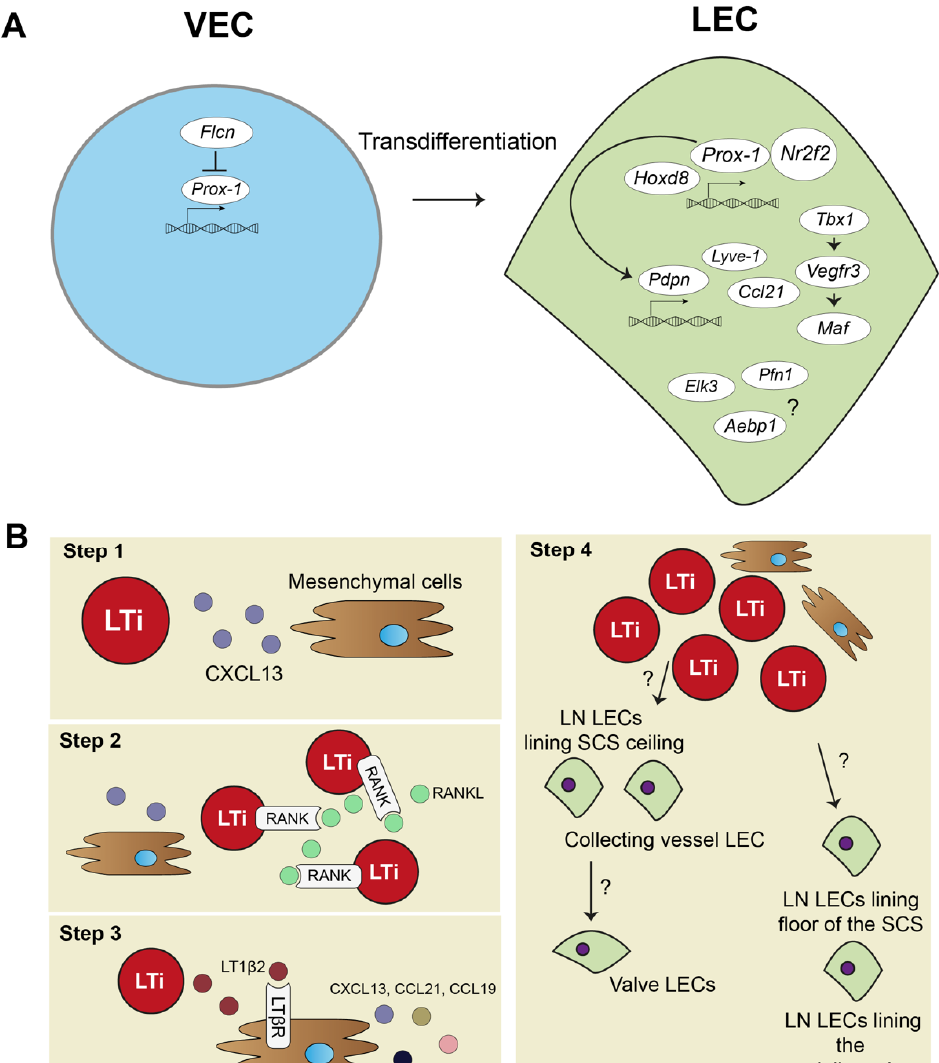
Figure 1. Lymphatic endothelial cell and lymph node embryonic development. ( A ) In embryonic development, lymphatic endothelial cells (LECs) mostly transdifferentiate from venous endothelial cells (VECs). Prospero homeobox protein 1 (Prox-1) is a master regulator of lymphatic fate. Homeobox d 8 (Hoxd8) can activate Prox-1 expression, and Prox-1 cooperates with Nuclear Receptor Subfamily2 Group F Member 2 (Nr2f2) to drive expression of other key peripheral LEC molecules, such as podoplanin(Pdpn), lymphatic vessel endothelial hyaluron receptor 1 (Lyve-1), chemokine (C-C motif) ligand 21 (Ccl21), and vascular endothelial growth factor receptor 3 (Vegfr3). Vegfr3 is also regulated by transcription factor T-box 1 (Tbx1) and can activate other transcription factors, such as Maf. Single cell RNA sequencing (scRNA-seq) data also suggested transcription factors, such as ETS Transcription Factor 3 (Elk3 ), or other protein coding RNAs, such as Profilin 1 ( Pfn1 ) and AE binding protein 1 (Aebp1), to be involved in lymphatic development, but their function is not yet clear. ( B ) Lymph node (LN) development follows several steps: (1) mesenchymal cells secrete chemokine (C-X-C motif) ligand 13 (CXCL13) to attract lymphoid tissue inducer (LTi) cells. (2) LTi cells cluster together and activate receptor activator nuclear factor κ B (RANK) and RANK ligand (RANKL) signaling. (3) RANK-RANKL signaling increases lymphotoxin α 1 β 2 (LT1 β 2), which activates lymphotoxin beta receptor (LT β R) on mesenchymal cells responding with more cytokine signaling and attracting more LTi cells. (4) Mesenchymal cells differentiate into stromal cell subsets of the LN, and LTi differentiate or attract LECs. Trajectory inference of scRNA-seq data showed that there are two developmental paths of the LN